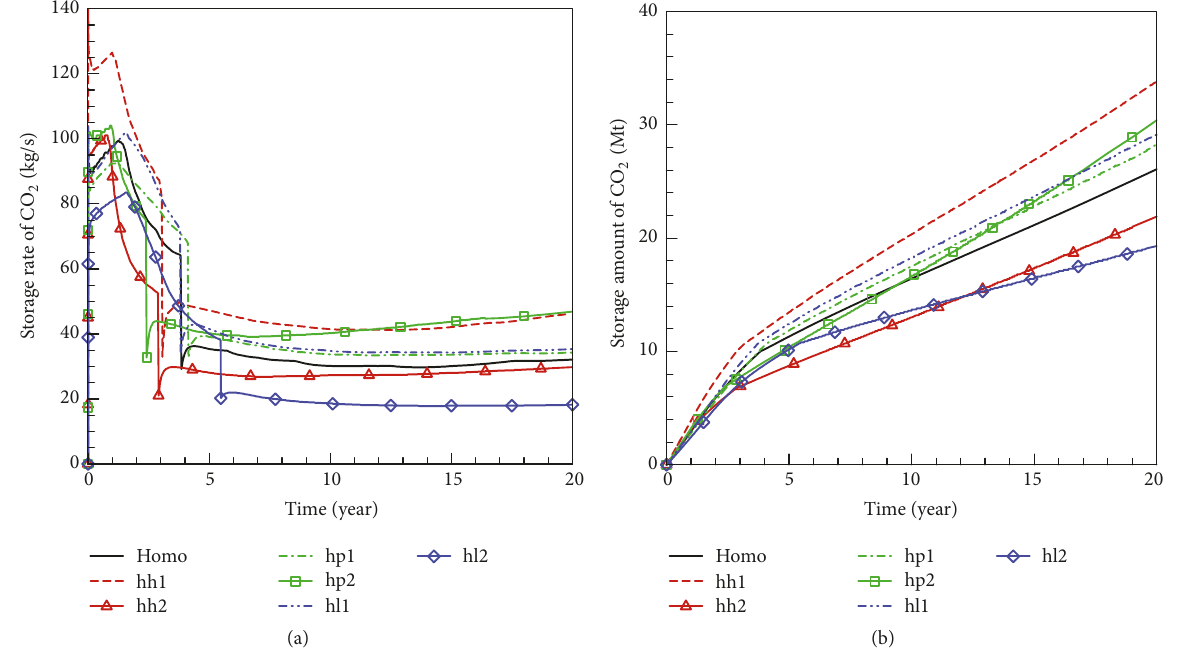
Figure 8: Storage rate (a) and storage amount (b) of CO 2 within reservoir versus time.